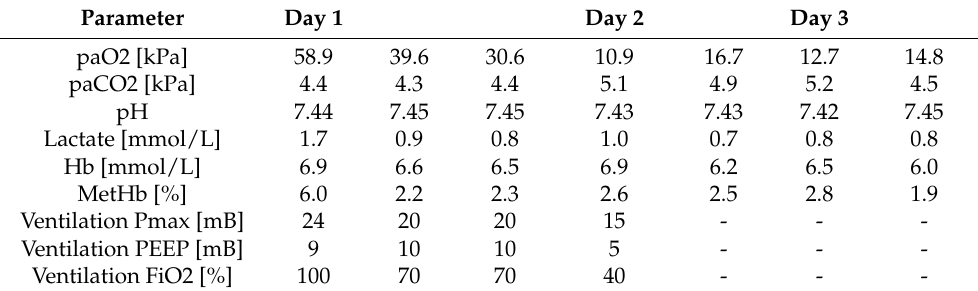
Table 1. Representative arterial blood gas analyses of the patient in relation to invasive mechanical